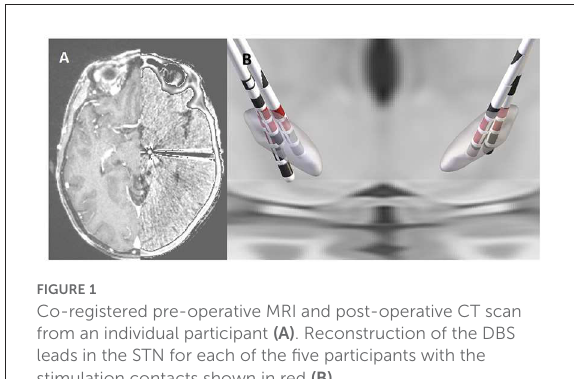
FIGURE1 Co-registered pre-operative MRI and post-operative CT scan from an individual participant (A) . Reconstruction of the DBS leads in the STN for each of the five participants with the stimulation contacts shown in red (B)